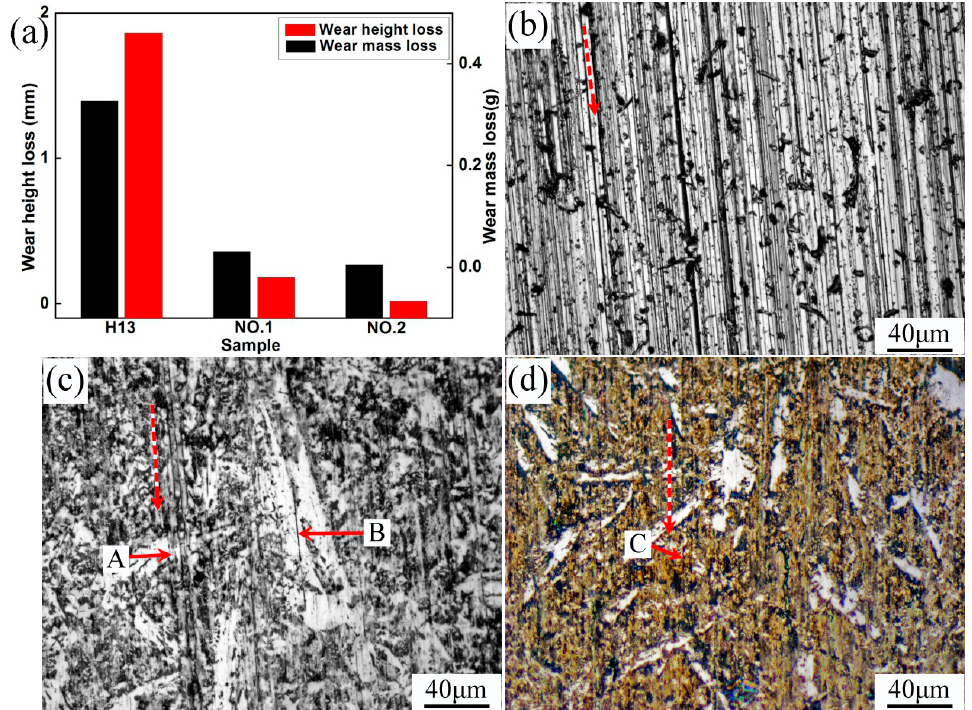
Figure 10. Wear resistance test results: ( a ) weight and height loss; ( b ) H13; ( c ) No.1; ( d ) No.2.